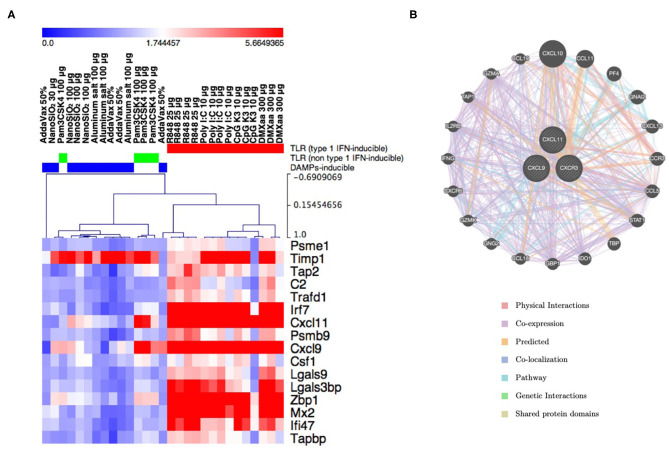
The expression pattern of individual lung biomarker genes characterizes the innate immunity induced by adjuvants. (A) Result of hierarchical clustering in lung biomarker genes and tested adjuvants. The clusters (TLR-related/type 1 IFN-inducing, TLR-related/non-type 1 IFN-inducing, and DAMP-inducing) are indicated by color bars at the top of the heat map. (B) Gene–gene interaction network constructed using GeneMANIA program. CXCL9 and CXCL11, which are included in the lung biomarker gene sets and influence the construction of the Pam3CSK4 cluster, along with their receptor CXCR3, are closely associated with genes related to Th1-, IFNγ-, and CTL-mediated immunity.